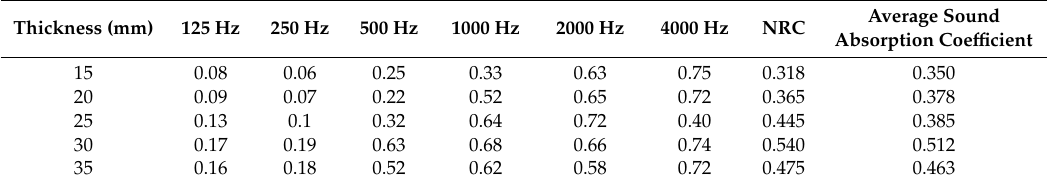
Table 4. Noise reduction coe ffi cient (NRC) and average sound absorption coe ffi cient for varied thickness